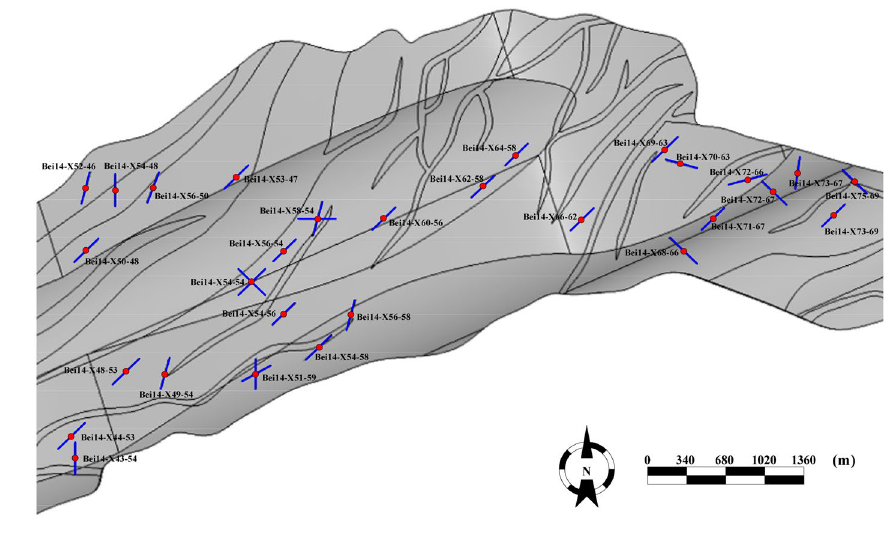
Fig. 5 The artificial fracture